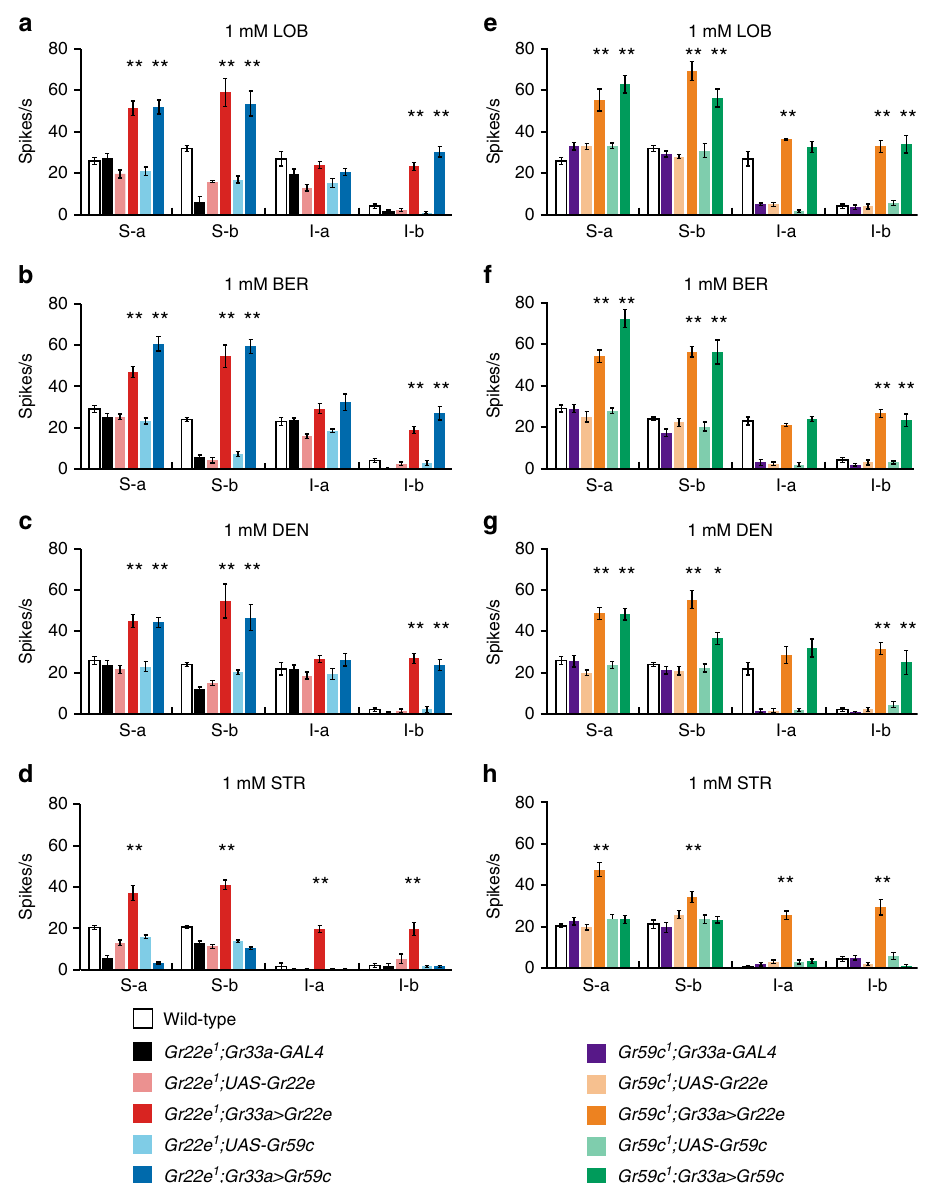
Fig. 4 Functional redundancy of Gr22e and Gr59c . Mean responses in fl ies of the indicated genotypes evoked by 1 mM stimulations with LOB a , e , BER b , f , DEN c , g , or STR d , h . n = 6 – 69. ANOVAs followed by Tukey or Dunnett T3 post hoc tests or Kruskal − Wallis tests followed by Mann − Whitney U post hoc tests as appropriate. All data are presented as means ± S.E.M. The asterisks indicate statistically signi fi cant differences (* p < 0.05, ** p < 0.01) from wild- type fl ies. Complete genotypes are listed in Supplementary Table In summary, expression of Gr22e in the Gr22e mutant and expression of Gr59c in the Gr59c mutant both rescue their respective mutant phenotypes, con fi rming the respective defects are attributable to loss of Gr22e or Gr59c . In addition, expression of Gr22e in the Gr59c mutant and Gr59c in the Gr22e mutant produce nearly identical responses to LOB, BER, and DEN. This indicates Gr22e can substitute for Gr59c and vice versa, except in the detection of STR.